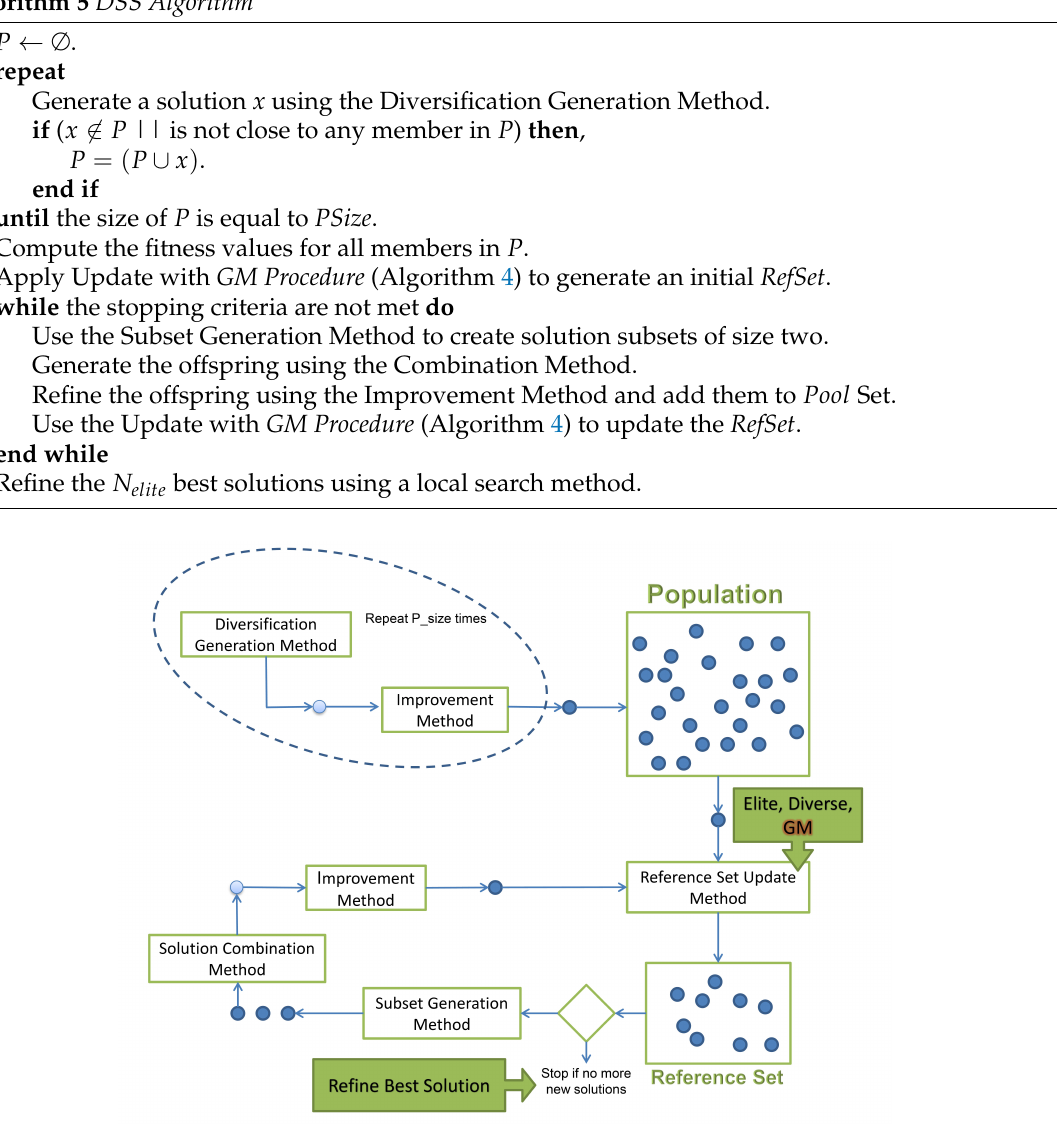
Figure 5. The structure of the DSS